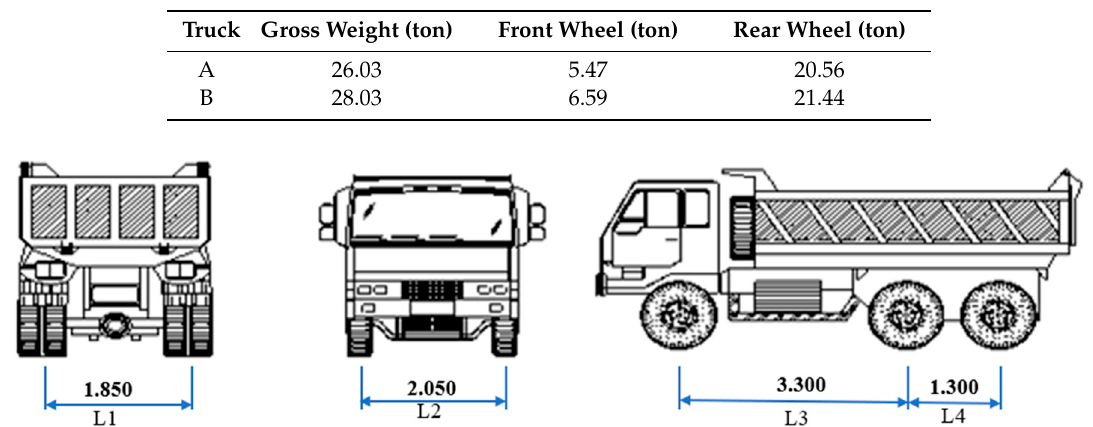
Table 1. Trucks load distribution.